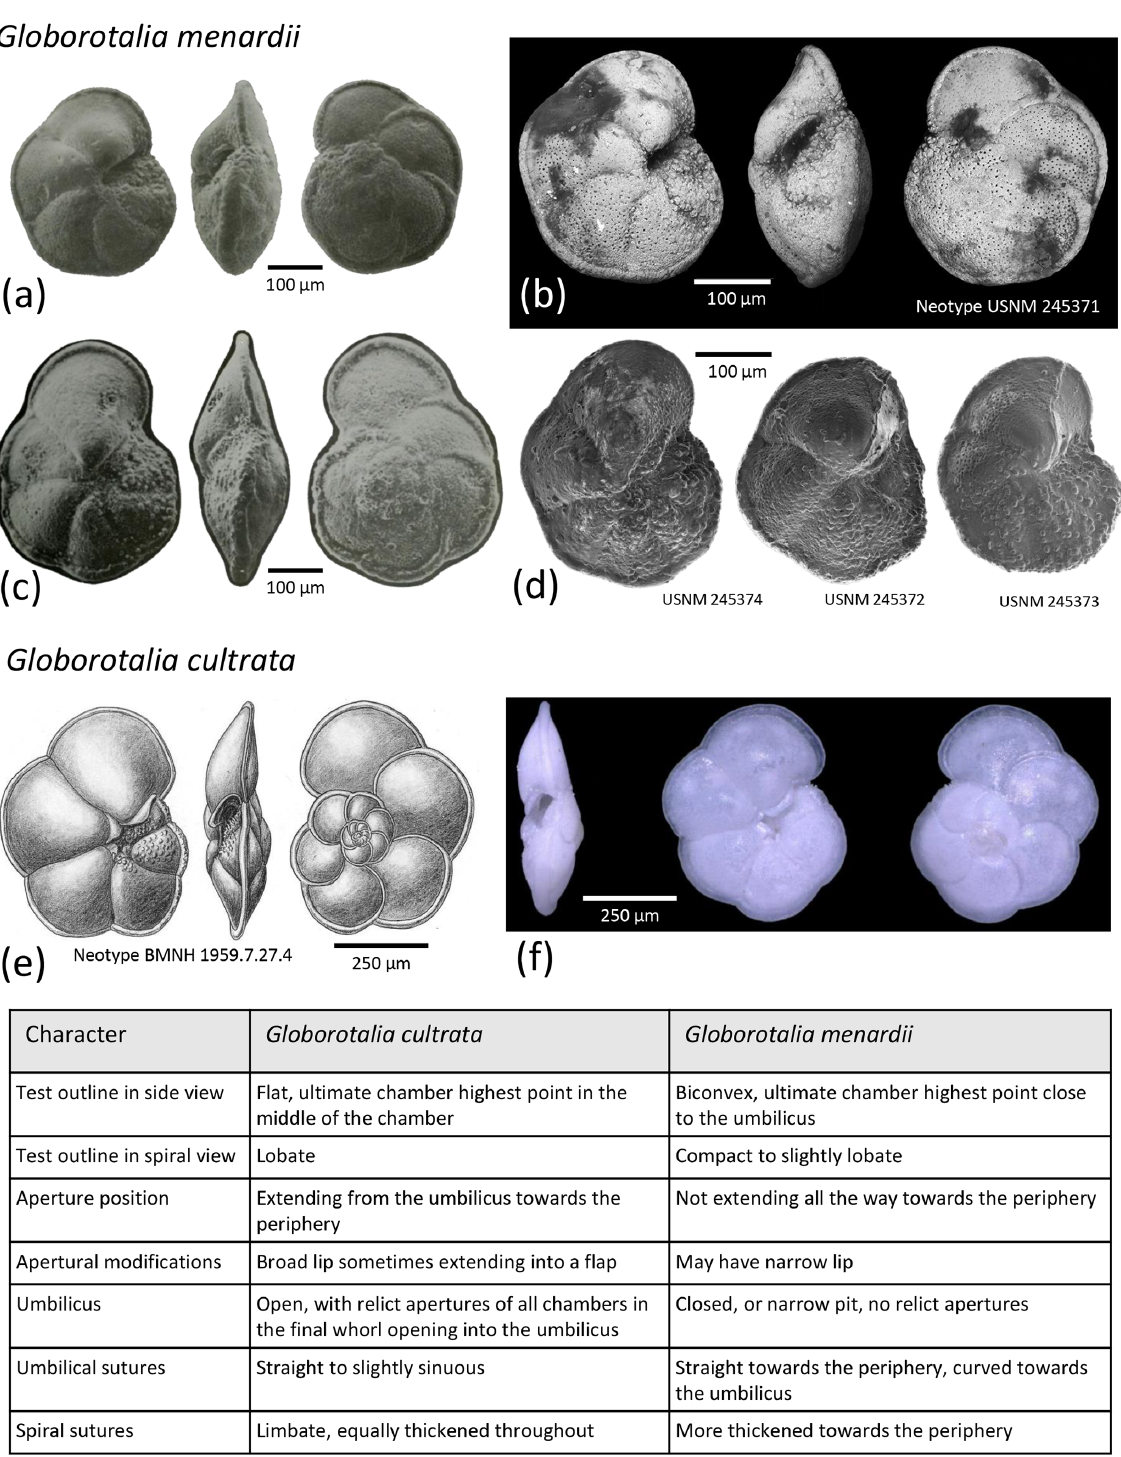
Figure 6. Neotype of Globorotalia menardii (Parker, Jones and Brady, 1865) as designated here with (a) being the specimen imaged by Stainforth et al. (1978) on their plate 2, fig. 1, and (b) the specimen labelled as type and deposited as such by Stainforth in the USNM collections and here designated as neotype. The specimen initially designated by Stainforth et al. (1978) as the neotype (c) deviates from all other specimens deposited by Stainforth at the USNM (a, d) and must be considered lost. (e) Neotype of Globorotalia cultrata (d’Orbigny, 1839) as designated and drawn by Banner and Blow (1960a), compared to (f) a light microscope image of a topotypical specimen extracted from Caribbean surface sediments (image by Adrian Baumeister). The table below the illustrations is listing key morphological characters differentiating the two